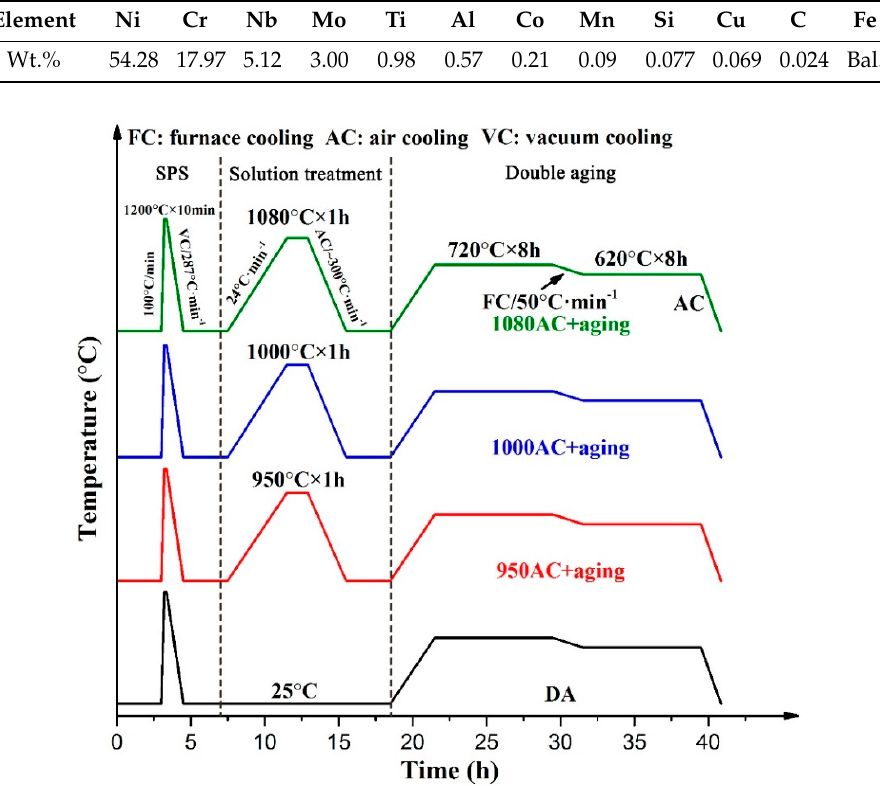
Figure 1. Schematic illustrations of spark plasma sintering (SPS) and the heat treatment cycles performed in this study.